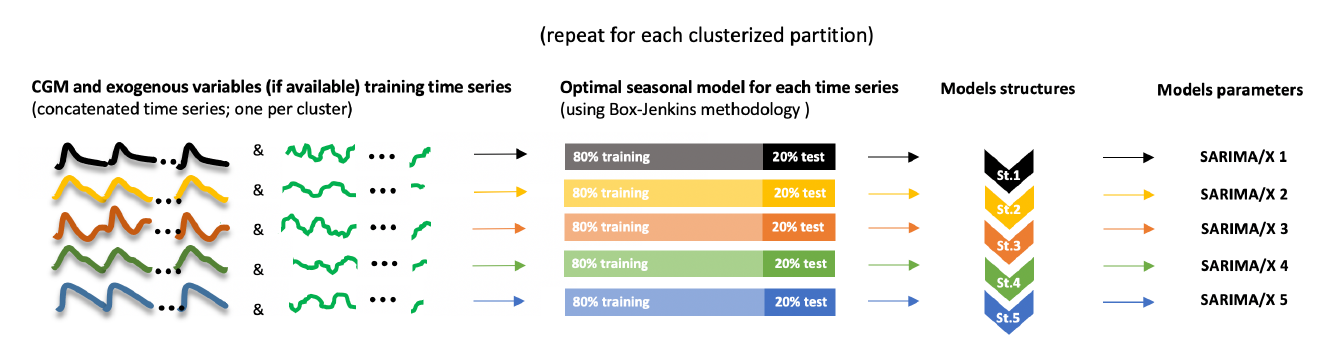
Figure 3. Local models identification process during the training phase. Data in a cluster was split in 80% for training and 20% for validation (see Section